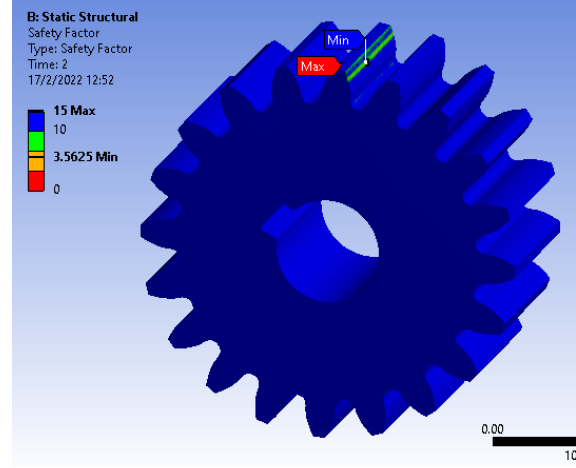
Figure 5. Pinion safety factor.